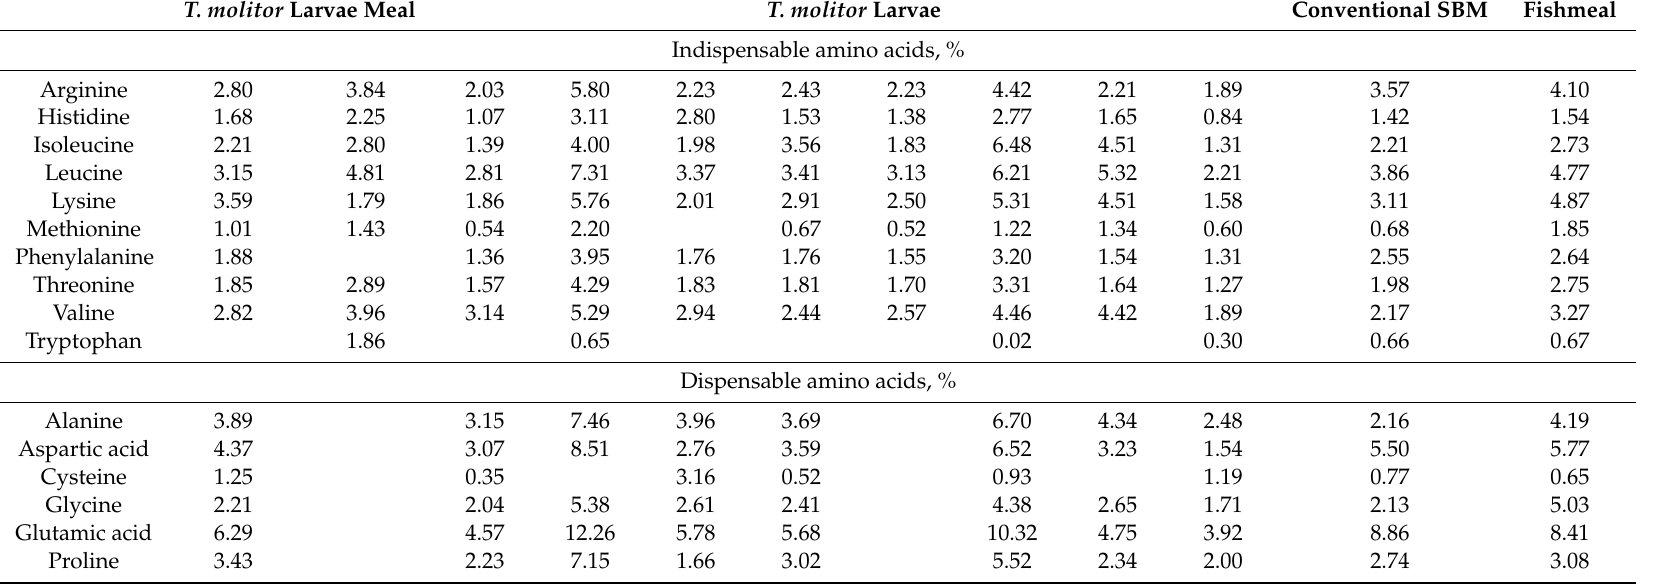
Table 2. Amino acid composition of Tenebrio molitor larvae or larvae meal (DM